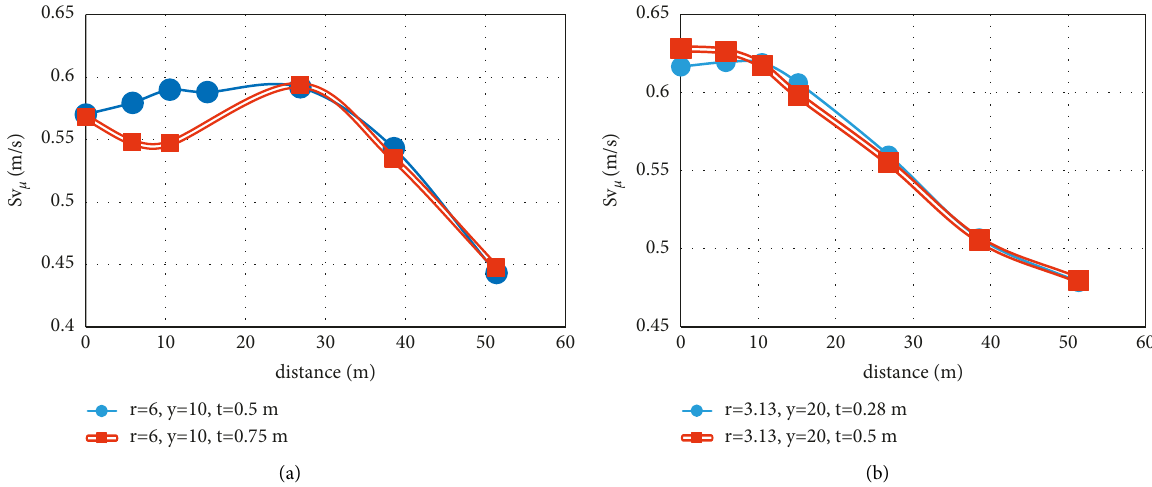
r=3.13, y=20, t=0.28 m r=3.13, y=20, t=0.5 Figure 15: The effect of change in tunnel lining thickness on ground surface velocity for models (a) 1 and 2 and (b) 5 and 35 of Table 1.